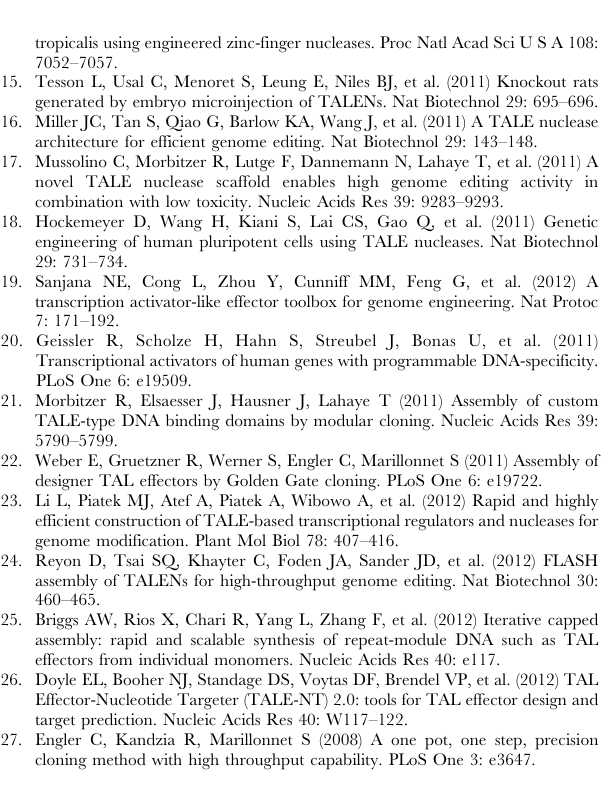
Table S1 Sequencing results of positive TALE construct colonies. 5 positive colonies were sent sequencing after PCR verification and restriction digestion detection. Sequencing results information including number of correct colonies, number of point mutant colonies and number of point mutant colonies were shown in the